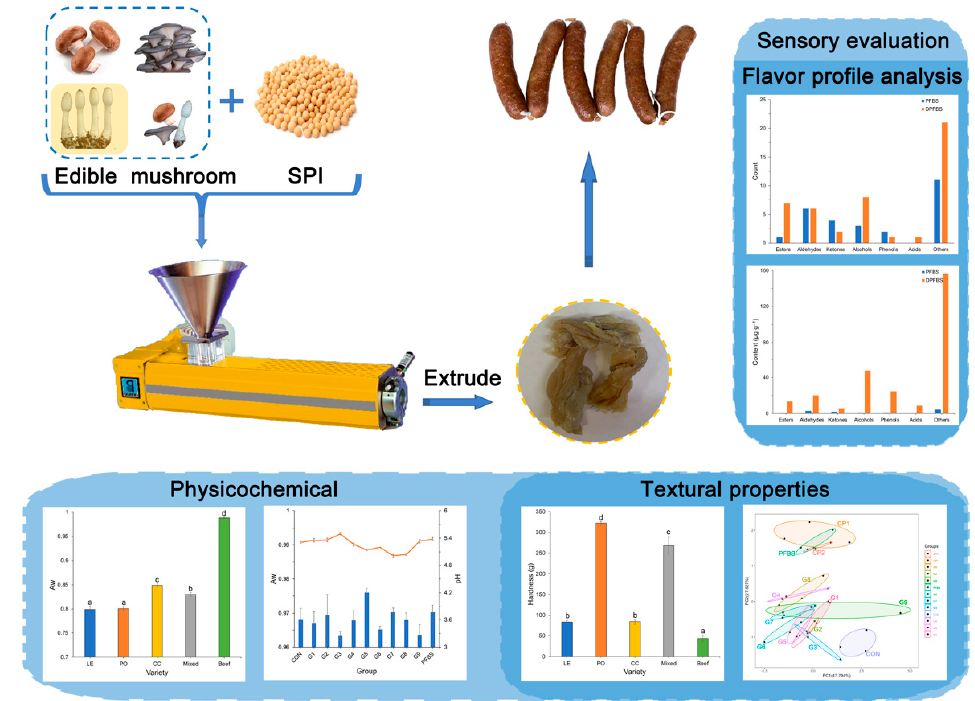
Figure 1. Schematic diagram of the preparation of mushroom-based meat sausage analogue